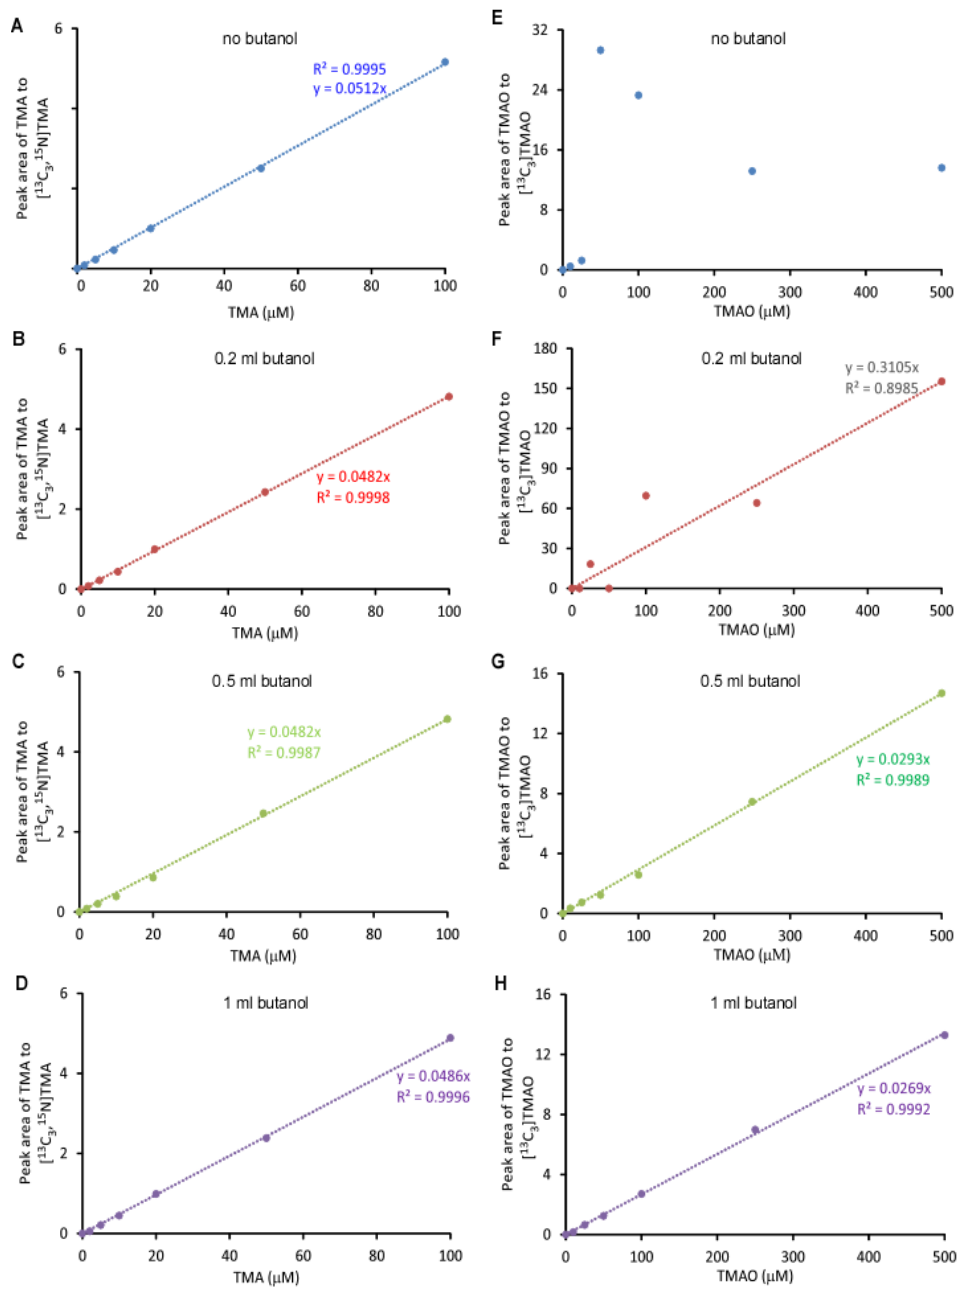
Figure 4. Standard curves for the LC/ESI/MS/MS analysis of TMA and TMAO with [ 13 C 3 , 15 N]TMA and [ 13 C 3 ]TMAO as internal standards, respectively. Here, 500 μL of varying concentrations of TMA and TMAO were mixed with 20 μL of 1 mM [ 13 C 3 , 15 N]TMA and 1 mM [ 13 C 3 ]TMAO and extracted with 2 mL hexane and varying volumes of butanol (no butanol ( A , E ), 0.2 mL butanol ( B , F ), 0.5 mL butanol ( C , G ), 1 mL butanol ( D , H )) in the presence of 1 mL 0.5 M NaOH. Then, analytes were transferred to the aqueous phase by adding 0.2 mL of 0.2 M formic acid. The analysis was performed using electrospray ionization in positive-ion mode with multiple reaction monitoring of precursor and characteristic product ions. The transitions monitored were mass-to-charge ratio ( m / z ): m / z 60 → 44, m / z 64 → 47, m / z 76 → 58 and m / z 79 → 61 for TMA, [ 13 C 3 , 15 N]TMA, TMAO and [ 13 C 3 ]TMAO, respectively. Curves were plotted as the peak area ratio of TMA to [ 13 C 3 , 15 N]TMA ( A – D ) and TMAO to [ 13 C] TMAO ( E – H ) versus concentration. Data were acquired in a Thermo Quantiva interfaced with a Vanquish LC system with 0.5 µ L injection to